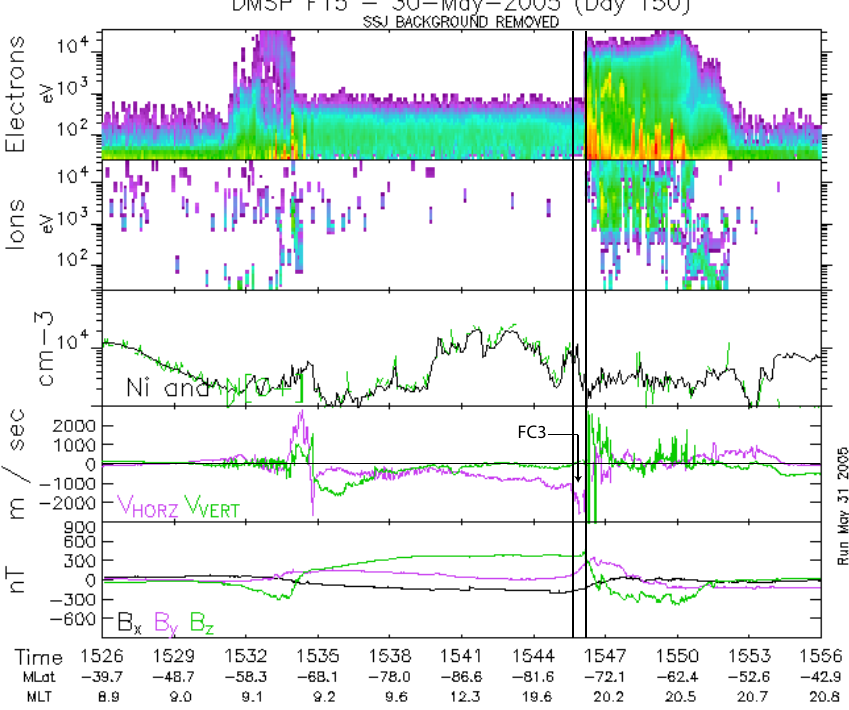
Fig. 8. DMSP F15 data obtained during the Southern Hemisphere pass from pre-noon to pre-midnight in the interval 15:26–15:56UT on 30 May 2005. Same format as in Fig.